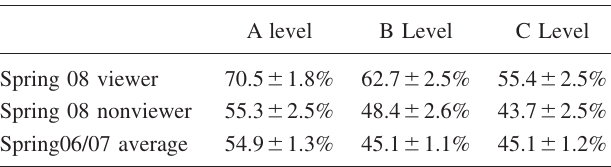
TABLE I. Average preflight correct rate for different groups of